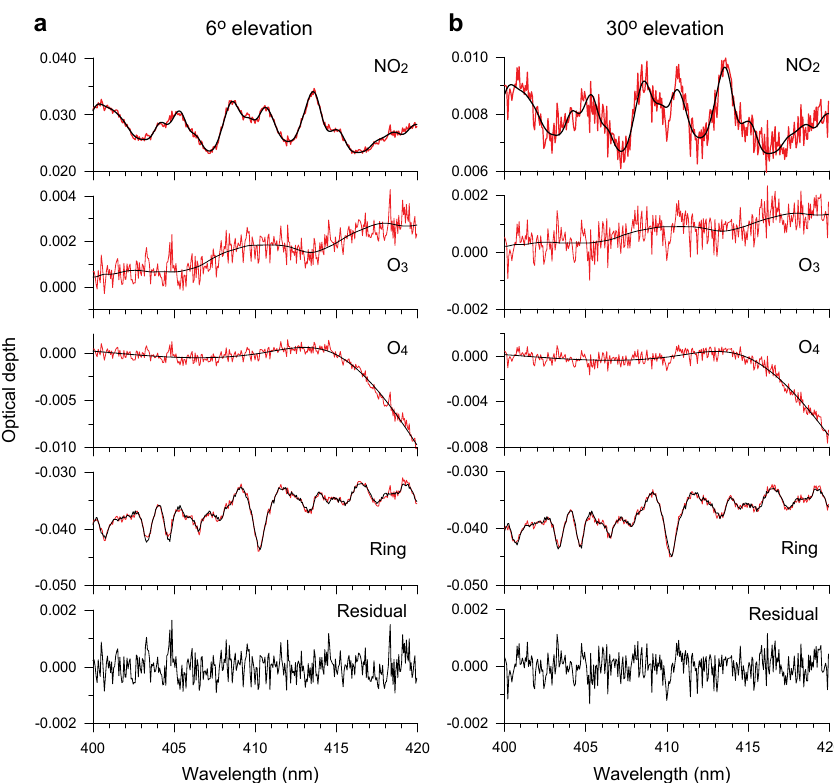
Fig. 2. Examples of the NO 2 retrieval for (a) high absorption (12 August 2008, 12:32 BJT, at 6 ◦ elevation angle, with NO 2 differential slant column density (DSCD) of 4.62 × 10 16 moleculescm − 2 ) and (b) low absorption (12 August 2008, 12:35 BJT, at 30 ◦ elevation angle, with NO 2 DSCD of 1.31 × 10 16 moleculescm − 2 ) . The black lines indicate the reference spectra scaled to the respective absorptions (red lines) in the measured spectra. At the bottom, the spectral residual (difference between measured spectra and fit result) are